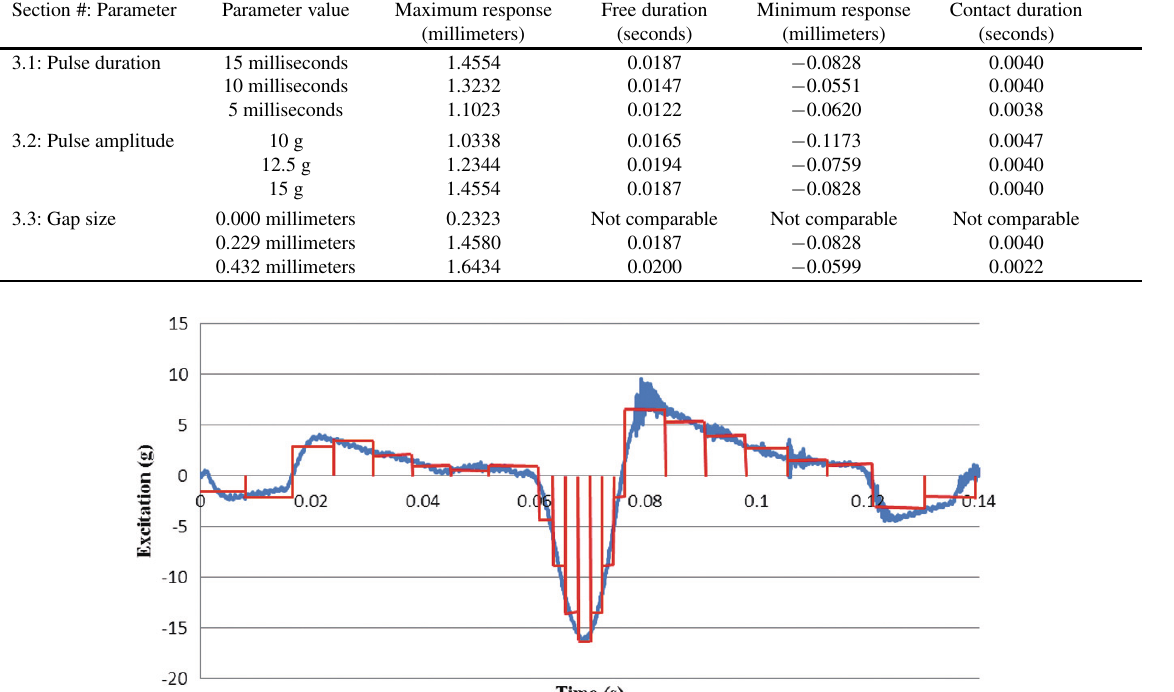
Table 2 Experimental results for three examined parameters